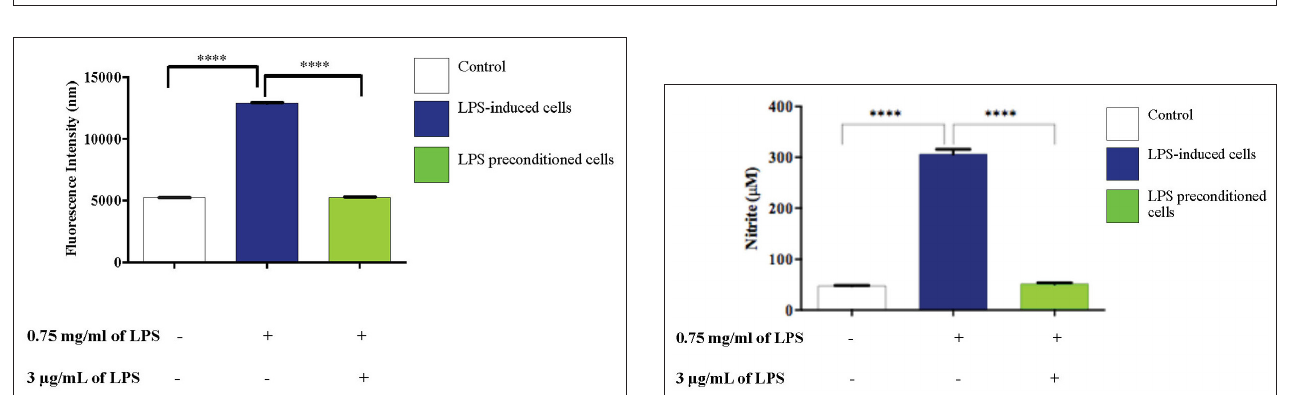
FIGURE 14 | Quantitative analysis of inflammatory cytokines and chemokines. (A) The Rat Cytokine Array detects multiple analytes in LPS- induced cells, LPS-preconditioned cells, and control cells. Spot densities were analyzed by scanning the membrane on a Biospectrum AC ChemiHR 40 densitometer, and data were normalized to control and expressed as fold change relative to the control. (B) Quantitative analysis in the arrays showed differences in cytokine and chemokine expression in LPS-induced cells, LPS-preconditioned cells, and control cells. Each experiment was performed in duplicate.